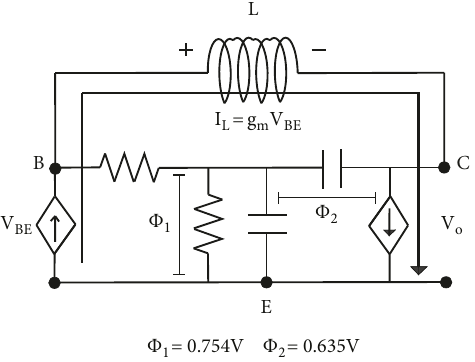
Figure 4: Equivalent-circuit approximation for inductor action. Built-in potentials at each junction are also